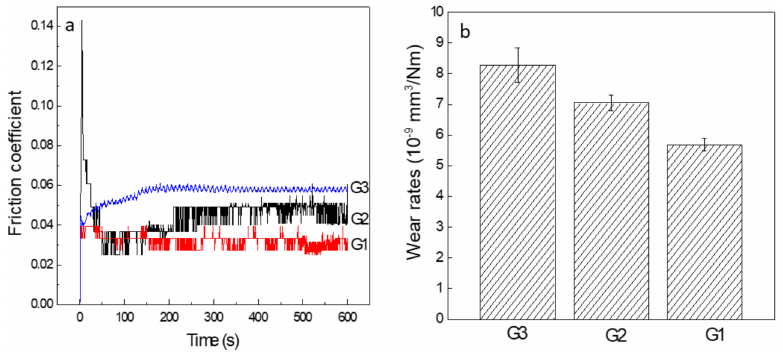
Figure 5. ( a ) Friction coefficients of the DLC films and ( b ) wear loss rates of the DLC